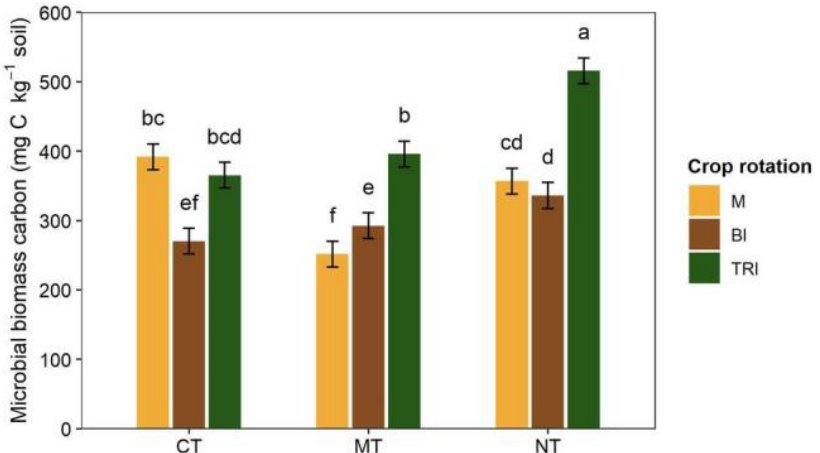
Figure 4. Effect of two-way interactions ‘Tillage × Rotation’ on soil microbial biomass carbon (SMBC, mg C kg − 1 soil). Tillage effect (No till: NT, moderate tillage: MT, and conventional tillage: CT) and Rotation effect (Monocropping: M, biennial: BI, and triennial: TRI). Data are averages ± standard errors. Different lowercase letters indicate significant differences between treatments ( p < 0.05).